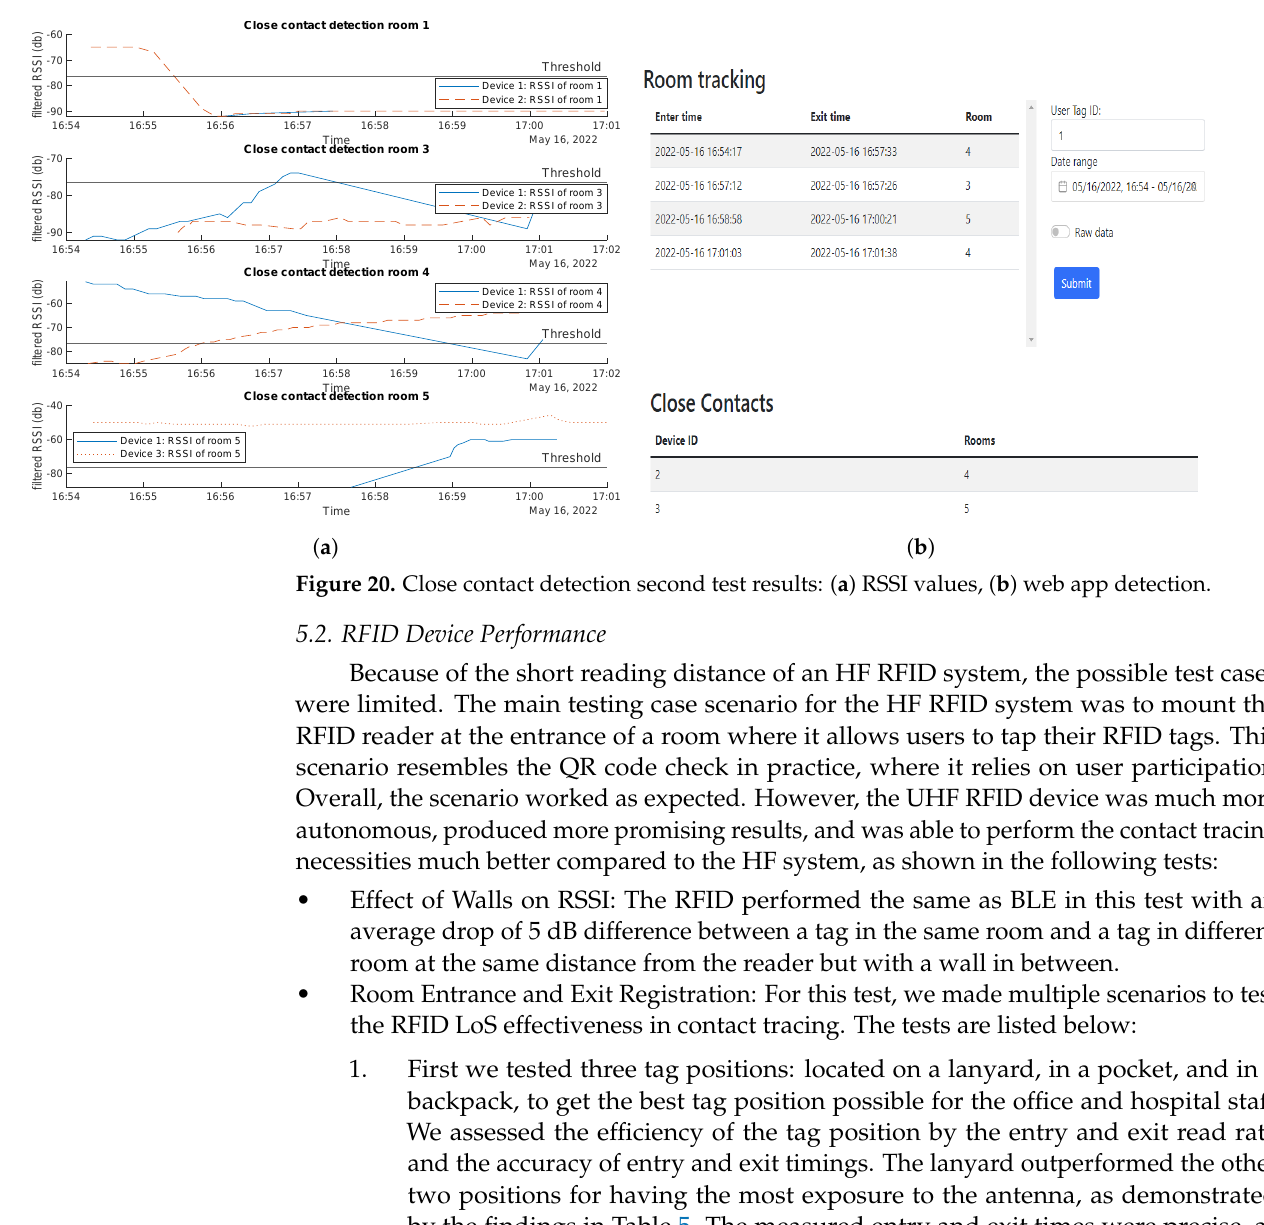
Figure 20a,b show the expected results of close contacts in RSSI values and through the web interface, respectively. One close contact happened in room 4 between tag 1 and 2 and another happened between tag 1 and 3 in room 5.